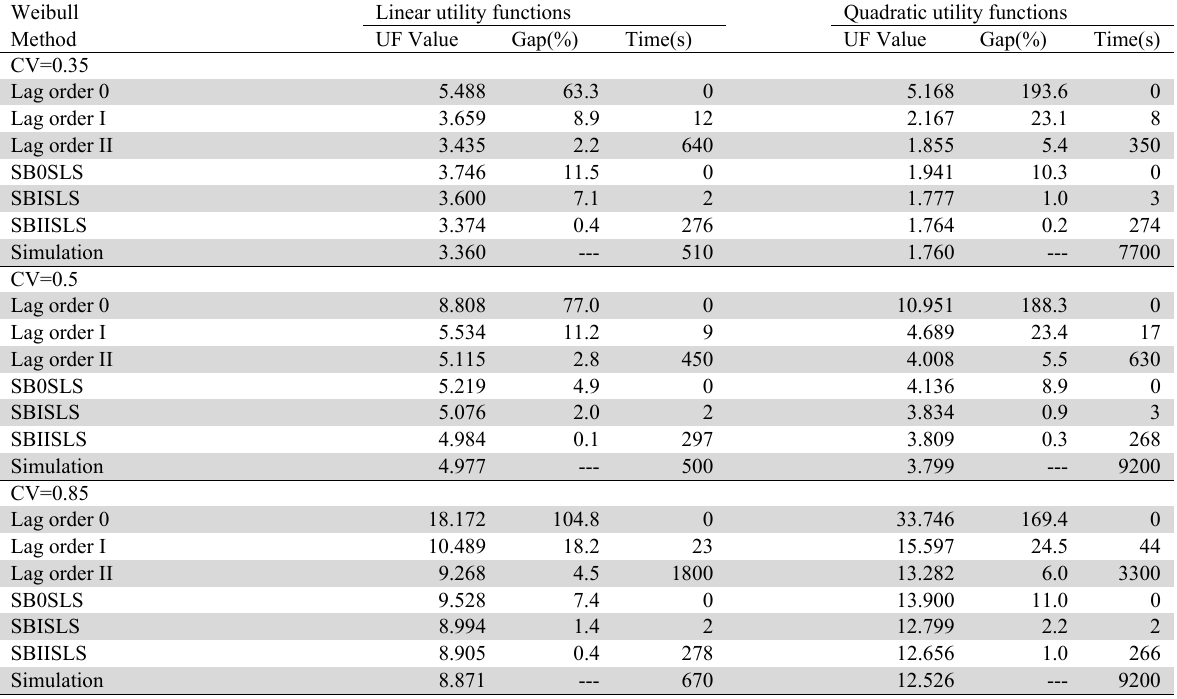
Optimization results of SBKSLS compared with lag order method and simulation. (cid:1840) (cid:3404) 11 , i.i.d. Weibull service times Weibull Linear utility functions Quadratic utility